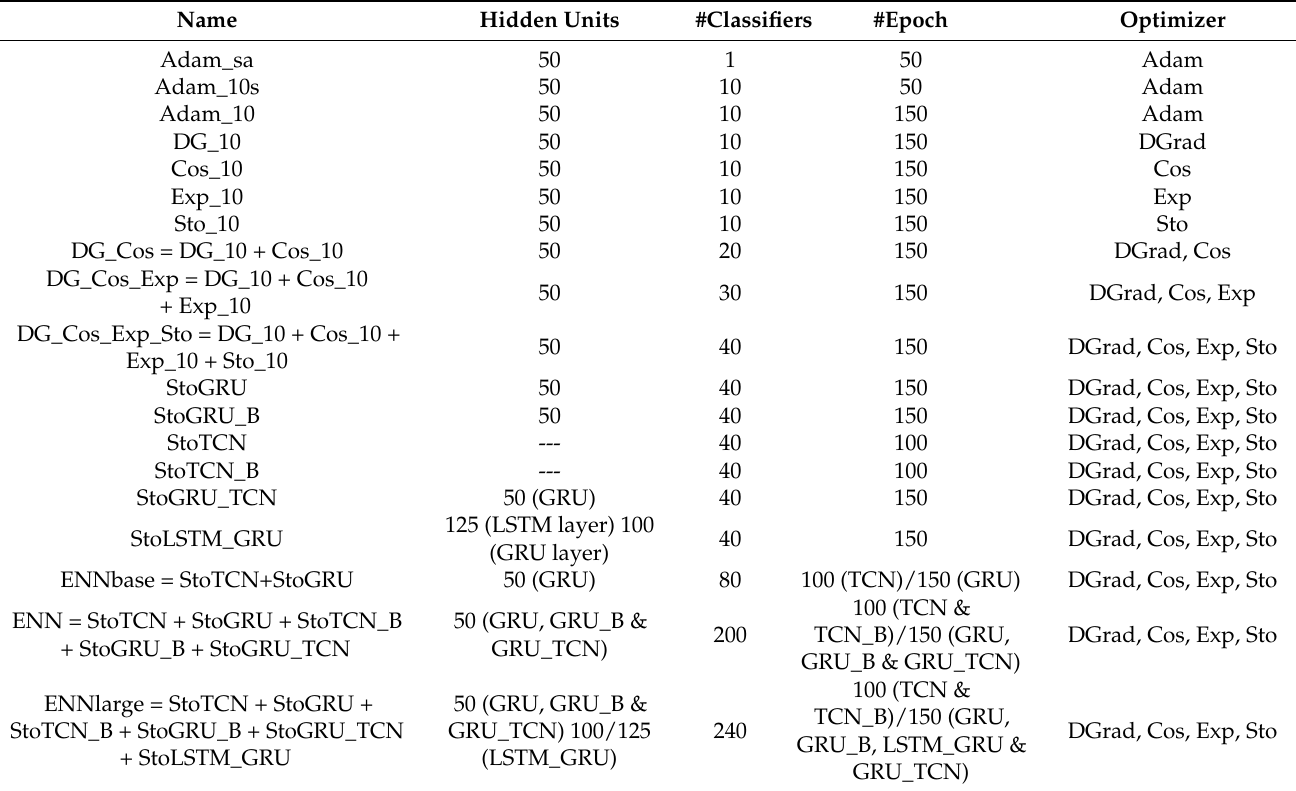
Table 3. Summary of tested